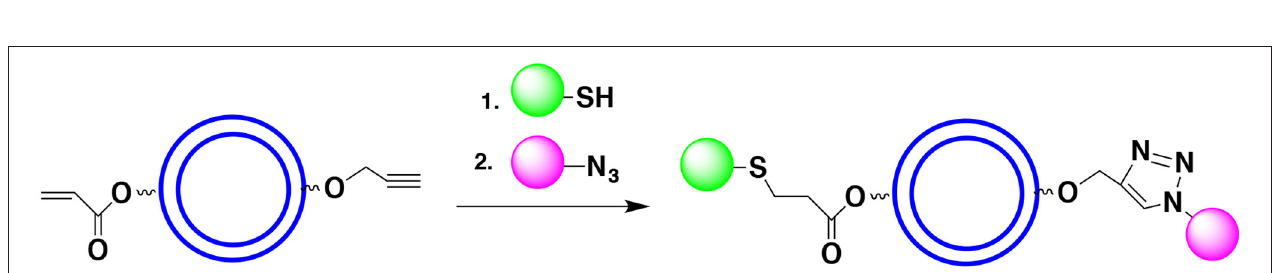
FIGURE 14 | Use of click reactions to introduce surface moieties may allow avoiding the use of protective groups. In the example shown the terminal acetylene (via a reaction with propargyl bromide) and α , β -unsaturated ester (via a reaction with acryloyl chloride) are introduced. The Huisgen reaction and Michael addition put in place desired surface